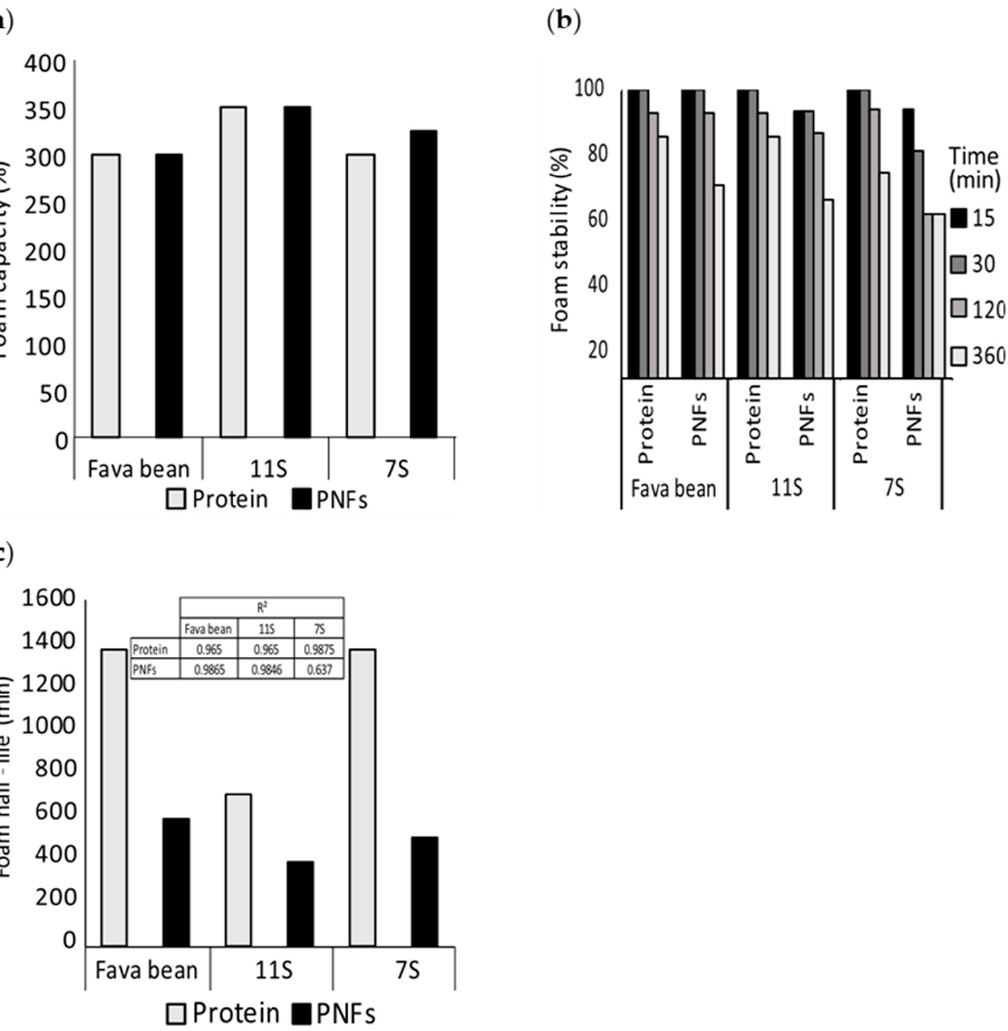
Figure 6. ( a ) Foaming capacity, ( b ) foam stability, and ( c ) foam half-life of fibrillated and non-fibrillated protein from fava bean and its globular fractions 11S and 7S. The foams were generated at pH 7 and concentration of 1 mg/mL. The insert in ( c ) shows the model fit (R 2 ). This was confirmed by confocal microscopy of the foam structure (Figure 7). The non-fibrillated samples seemed to have a more substantial fluorescent film of air bubbles and a more uniform distribution of small and large bubbles. Only some of the peptides formed during incubation at low pH and high temperature contribute to the fibril for- mation [31]. When investigating the foaming properties of fibrillated 11S protein from soybean as a mixture and when separated into a pure fibril and pure peptide fraction, Wan et al. (2021) concluded that the peptides, and not the PNFs, contributed to the stability of the foams [19]. In contrast to the earlier study by our research group [20], we found that when fibrillated mung bean protein was separated into a pure fibril fraction and a